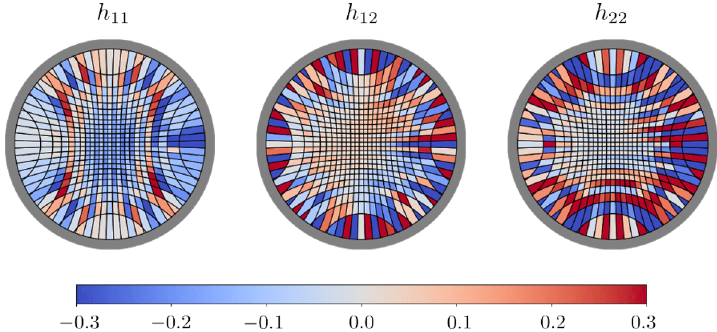
Figure 4. Components of the reconstructed metric tensor perturbation corresponding to the ground state of a mass deformed Hamiltonian, with the deformation located at a single site located along the positive x -axis. The boundary relative error is E bdy ≈ 0 . 62